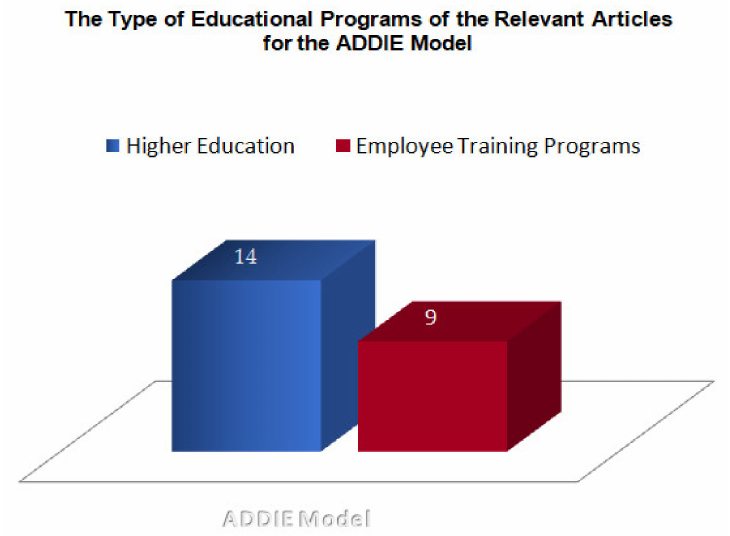
Figure 6. The type of educational programs of the relevant articles for the ADDIE